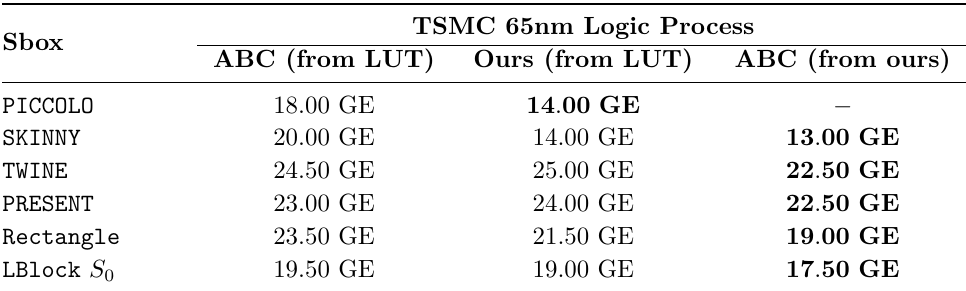
Table 11: Comparison of area-optimized synthesis on the TSMC 65nm